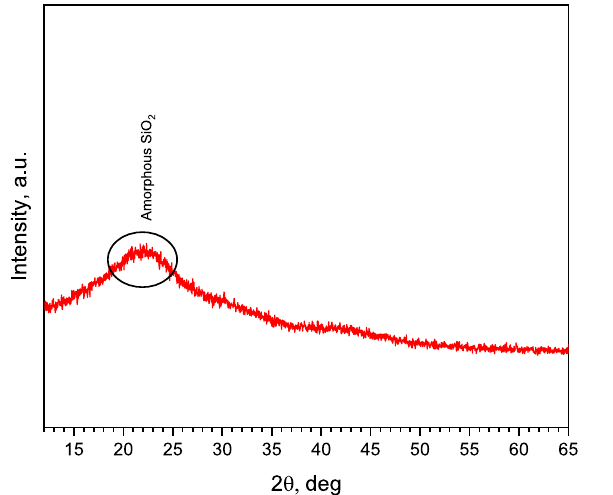
Figure 11. X-ray diffraction pattern of silica aerogel.